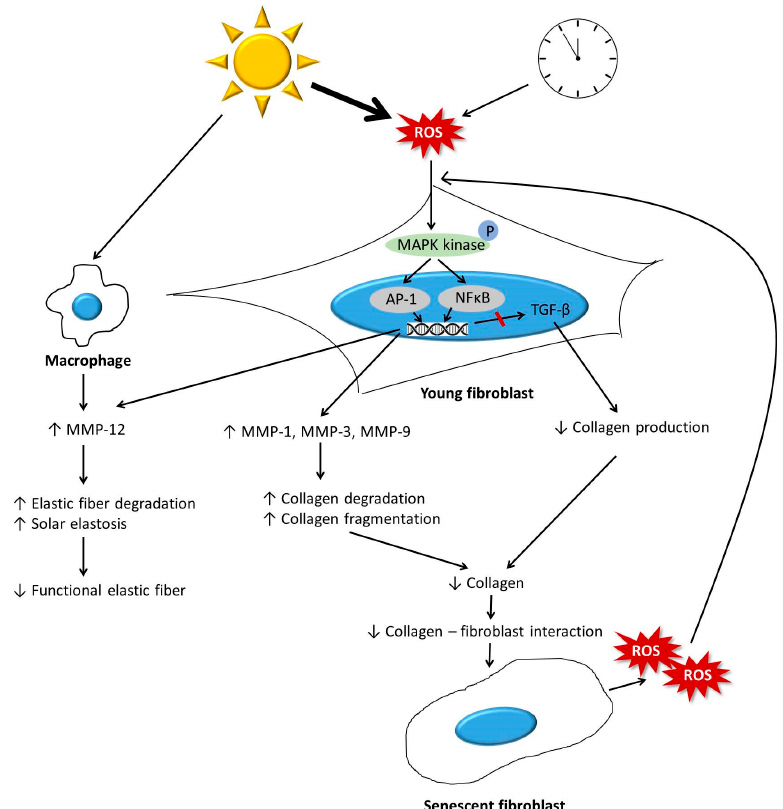
Figure 1. Schematic illustration showing the changes in fibroblasts, collagen, and elastic fibers in the dermal aging process. Reactive oxygen species (ROS) generated in the aging process activate mitogen-activated protein kinases (MAPKs) and induce transcription factors, including activator protein 1 (AP-1) and nuclear factor- κ B (NF- κ B). This activation increases matrix metalloproteinase (MMP) expression and inhibits transforming growth factor- β (TGF- β ) signaling, which leads to collagen fragmentation and decreased collagen biosynthesis. This hinders the mechanical interaction between fibroblasts and the extracellular matrix (ECM), and consequently reduces the size of dermal fibroblasts. Aged fibroblasts produce a greater amount of ROS that further increases the expression of MMPs and inhibits TGF- β signaling, creating a positive feedback loop that accelerates dermal aging. MMP-12 secreted from fibroblasts and macrophages plays a crucial role in the development of solar elastosis and in the reduction of functional elastic